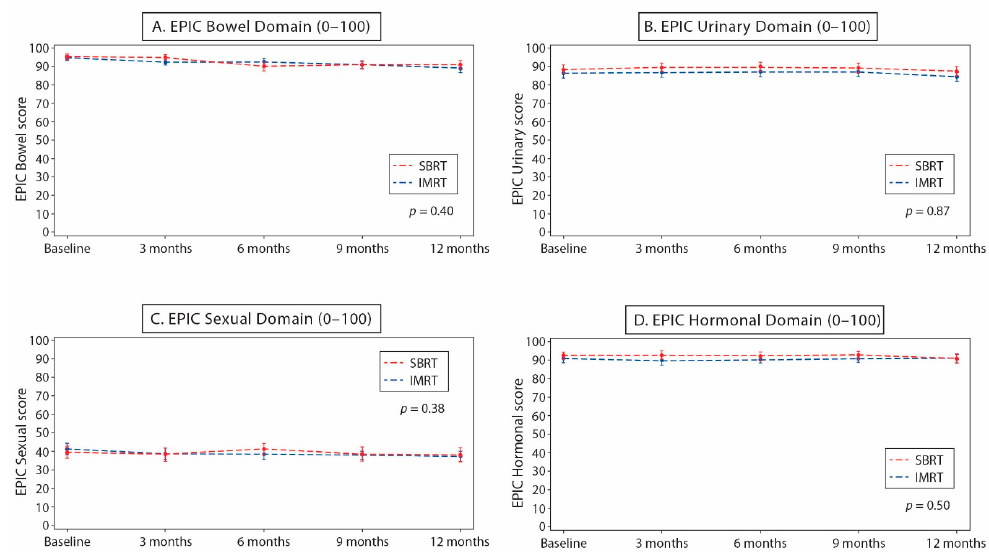
Figure 2. Mean (95% confidence interval) Expanded Prostate Cancer Index Composite questionnaire (EPIC) score over time for stereotactic body radiotherapy (SBRT) and conventional fractionated radiotherapy (CFRT): ( A ) bowel domain; ( B ) urinary domain; ( C ) sexual domain; and ( D ) hormonal domain. Abbreviations: EPIC, Expanded Prostate Cancer Index Composite questionnaire; SBRT, stereotactic body radiotherapy; CFRT, conventional fractionated radiotherapy. Table 2. Patient-reported quality of life: Expanded Prostate Cancer Index Composite questionnaire (EPIC) score change at 1 year from baseline.